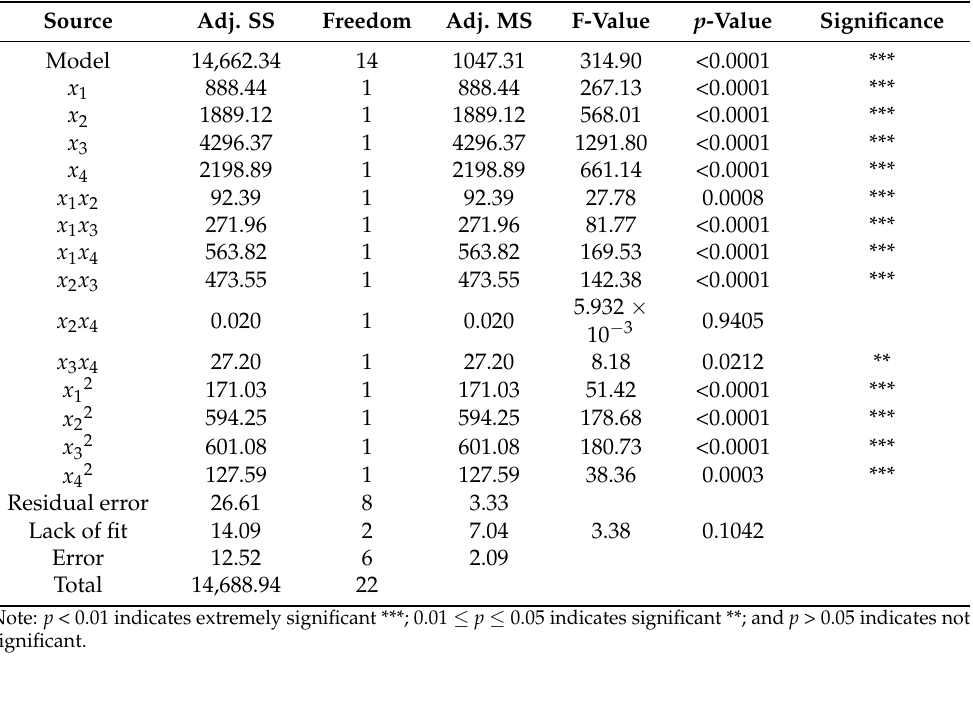
Table 5. Variance analysis of the test